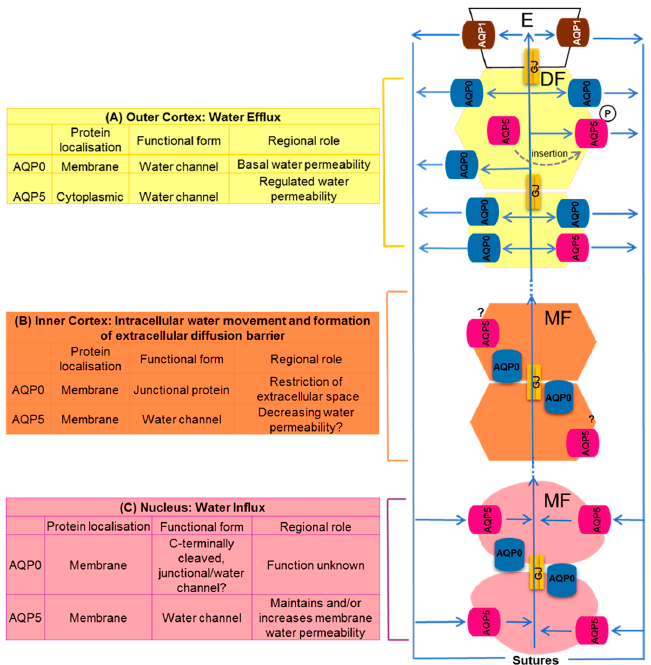
Figure 3. Schematic diagram detailing the relative contributions of AQP0 and AQP5 to fluid circulation in the lens. ( A ) On the anterior surface of the lens cell AQP1 contributes to the water permeability (P H2O ) of the epithelial cells. At the equator in the outer cortex of the lens basal water efflux is proposed to be mediated by water channels formed from the abundant AQP0. However, in this region of the lens water efflux can be up regulated by the shuttling of AQP5 water channels from an inactive cytoplasmic pool of channels to the membrane to form active water channels following phosphorylation by activation of yet to be identified signaling pathways in the lens; ( B ) in the inner cortex water fluxes are preferentially carried away from the lens core via an intracellular pathway mediated by gap junction channels. In this region AQP0 functionality shifts from being a water channel to a junctional protein that reduces P H2O and narrows the extracellular space to form a barrier to extracellular diffusion. In this region, it